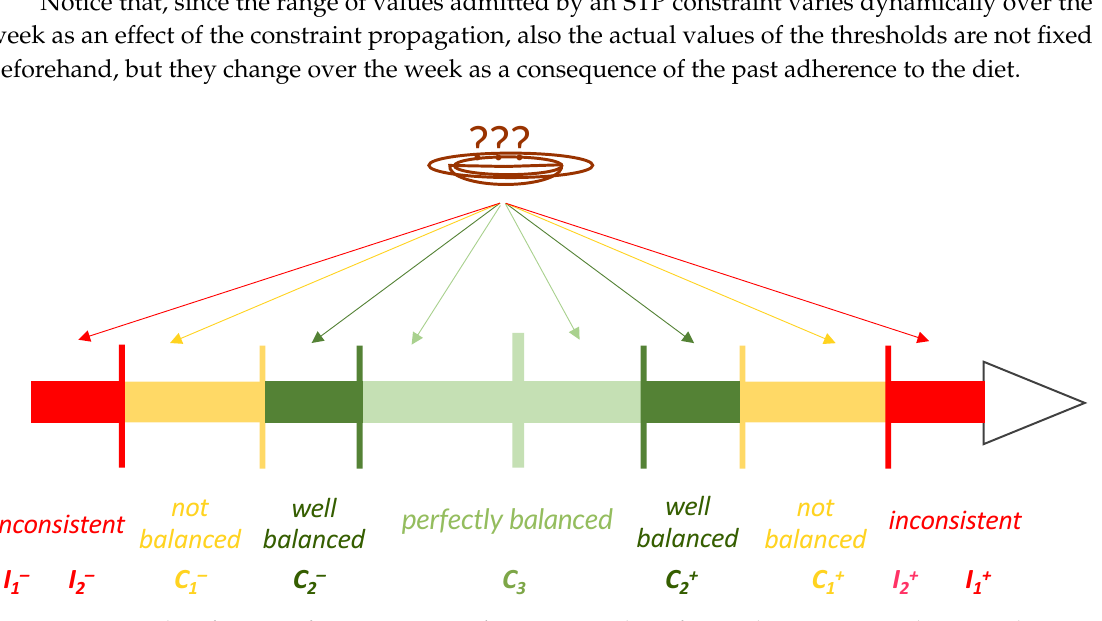
Figure 3. Classification of an inconsistent/consistent value of a meal’s energy supply given the minimum and maximum value of an STP constraint. The figure represents the range [ min , max ] admitted by an STP constraint (represented as an edge as in Figure